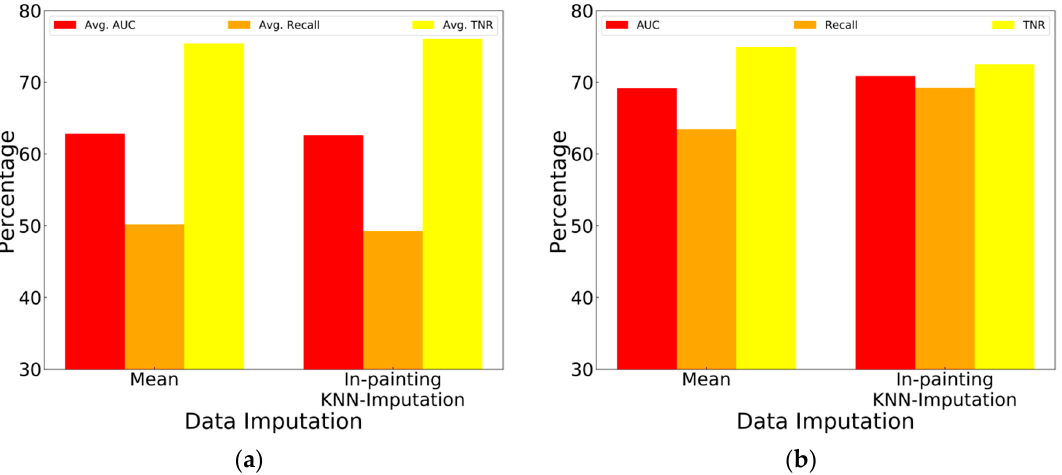
Figure 14. Classification results on data filled with different imputation approaches: ( a ) Average of all approaches; ( b ) The best approaches (highest AUC).